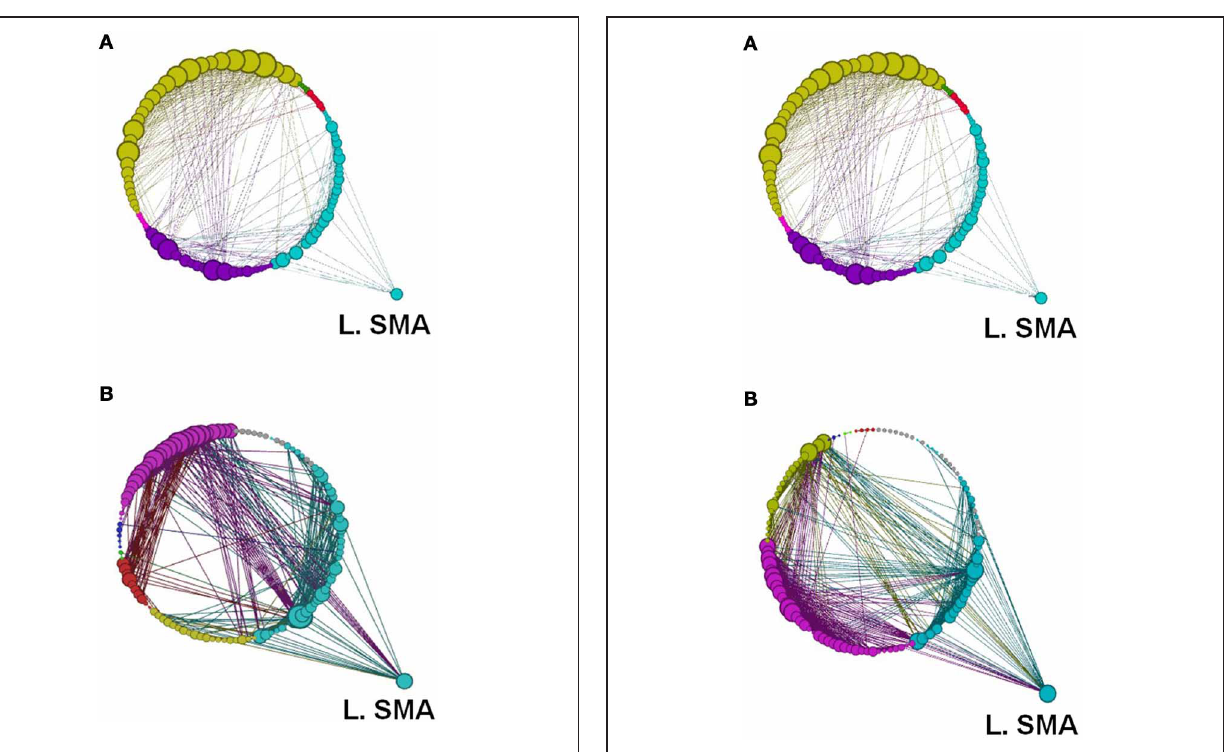
FIGURE 13 | Network modularity following the implicit SRTT, in the same format as Figure